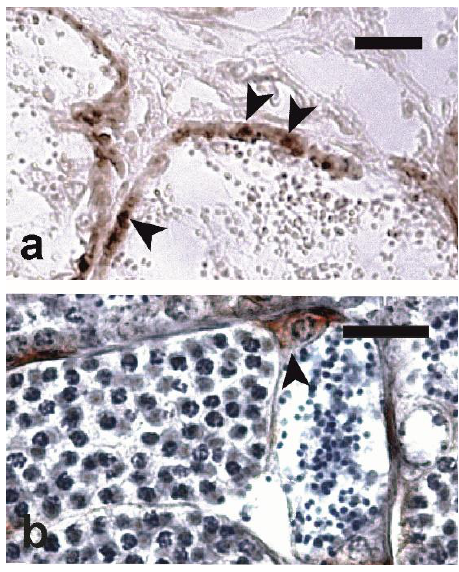
Figure 2. Micrographs of testis sections of meagre immunostained with ( a ) anti-oct4 antibodies (Trial 1) and ( b ) anti-vasa antibodies (Trial 2). Intralobular positive cells (arrowheads) are stained in brown. In (b), Mayer’s haematoxylin was used as a nuclear counterstain. Magnification bars = 20 µm.